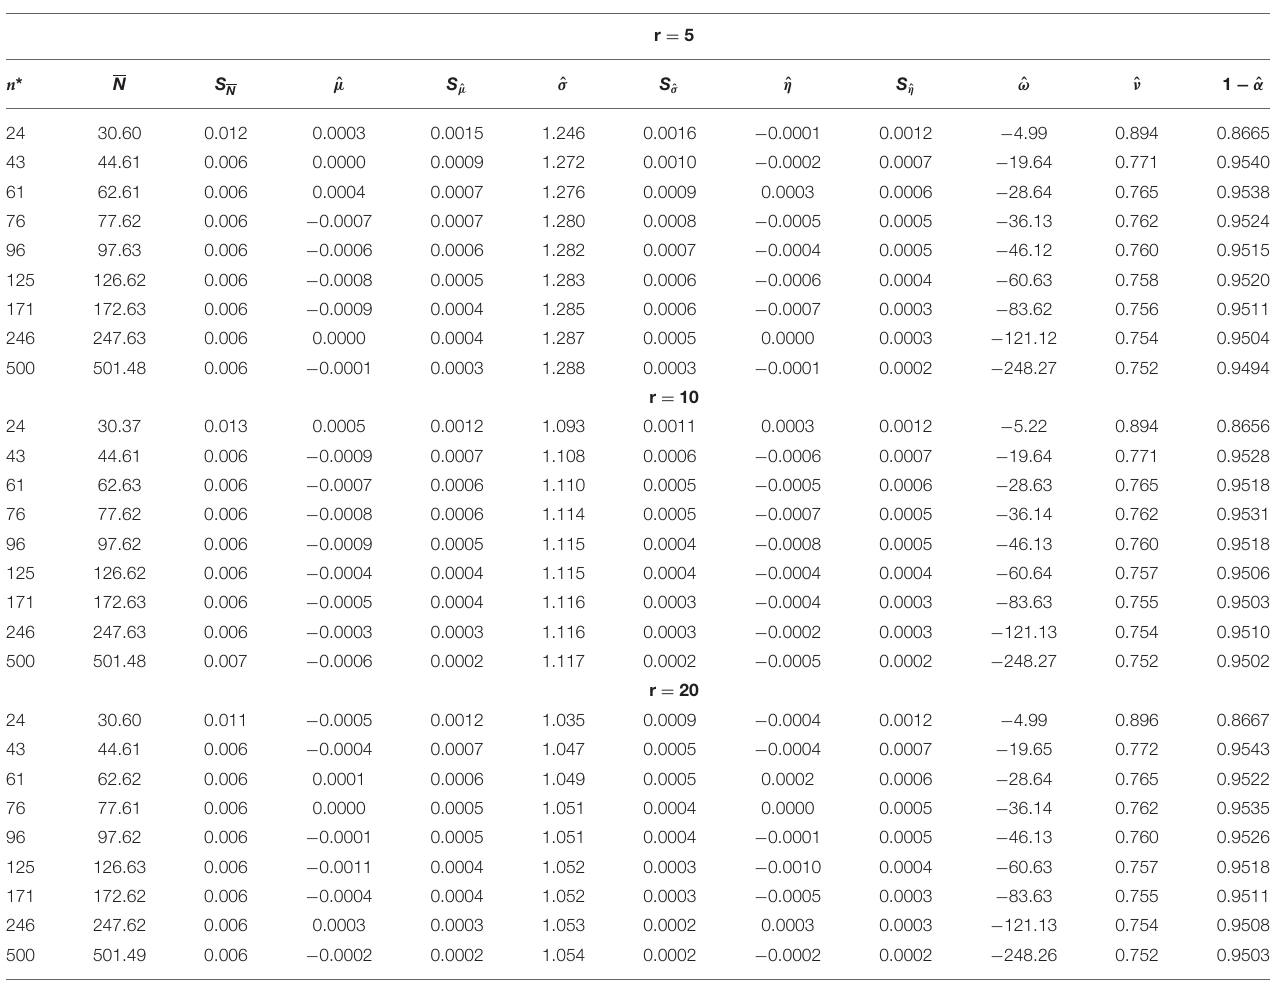
TABLE 4 | Three–stage estimation of the inverse coefficient of variation for underlying T ( r ) , r